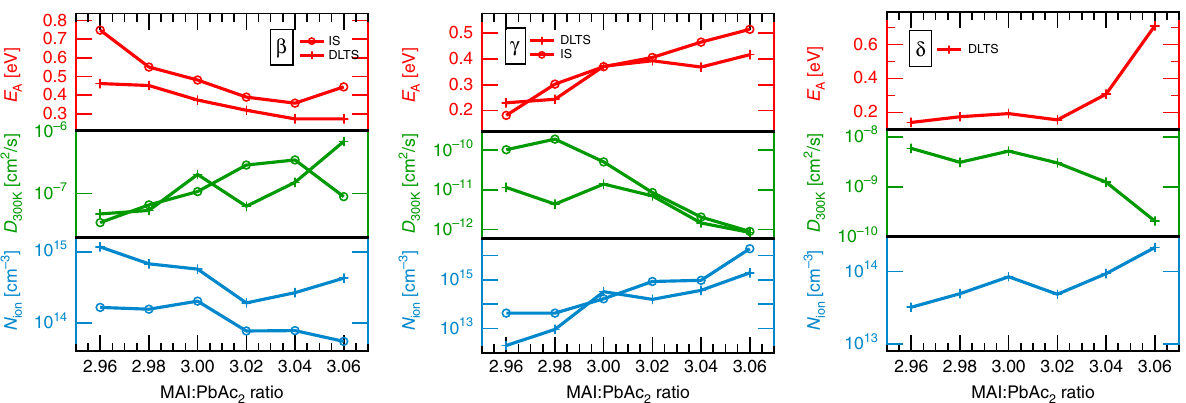
Fig. 3 Defect parameters for ionic species β , γ , and δ . Activation energy E A (red), diffusion coef fi cient D 300 K at 300 K (green) and ionic defect concentration N ion (blue), extracted by IS (circles) and DLTS (crosses) for all perovskite solar cells with stoichiometric ratio of precursor solution (MAI: PbAc 2